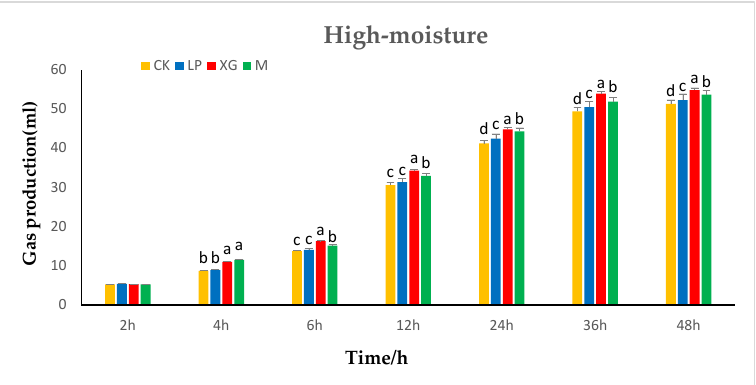
Figure 1. Effects of additives on the in vitro gas production in rumen of high-moisture content Stylosanthes silage. The effects of additives on in vitro gas production in the rumen of low-moisture con- tent Stylosanthes silage are shown in Figure 2. At 2 h, the additives did not have a signifi- cant effect on in vitro gas production by Stylosanthes silage ( p > 0.05). From 4 h to 12 h, the in vitro gas production in the xg and LP + xg treatment groups was significantly higher than that in the LP treatment group and control group ( p < 0.05). There was no significant difference in in vitro gas production between the LP treatment group and the control group ( p > 0.05). From 24 h to 48 h, the in vitro gas production in the xg treatment group was the highest, followed by the LP + xg treatment group and the LP treatment group. The in vitro gas production in the three treatment groups was significantly higher than that of the control group ( p < 0.05). From 36 h to 48 h, there was hardly any difference in the in vitro gas production among the groups, and it gradually stabilized and reached the highest value.